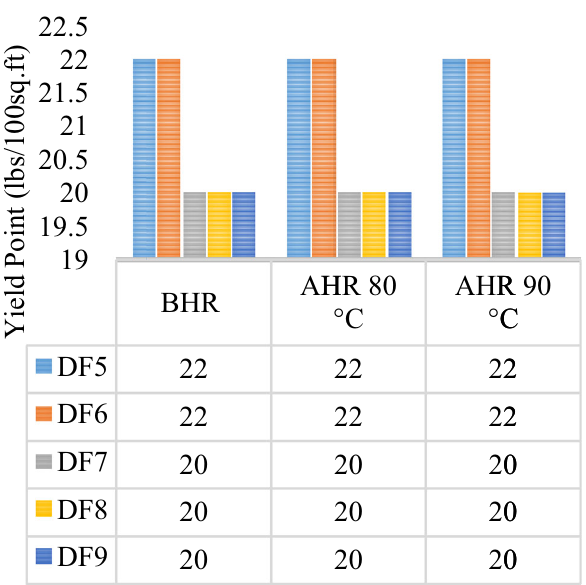
Fig. 9 Variation of YP after hot rolling